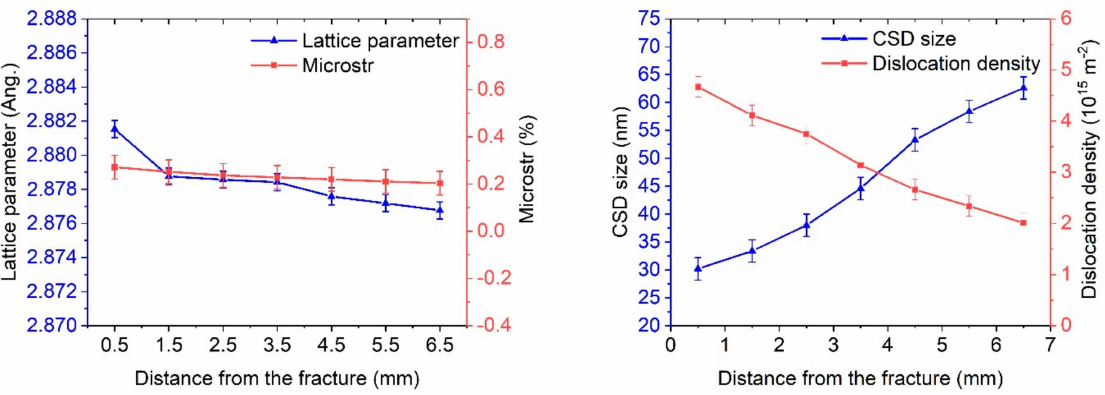
Figure 11. X-ray diffraction analysis after fatigue test of CR + requenching samples.